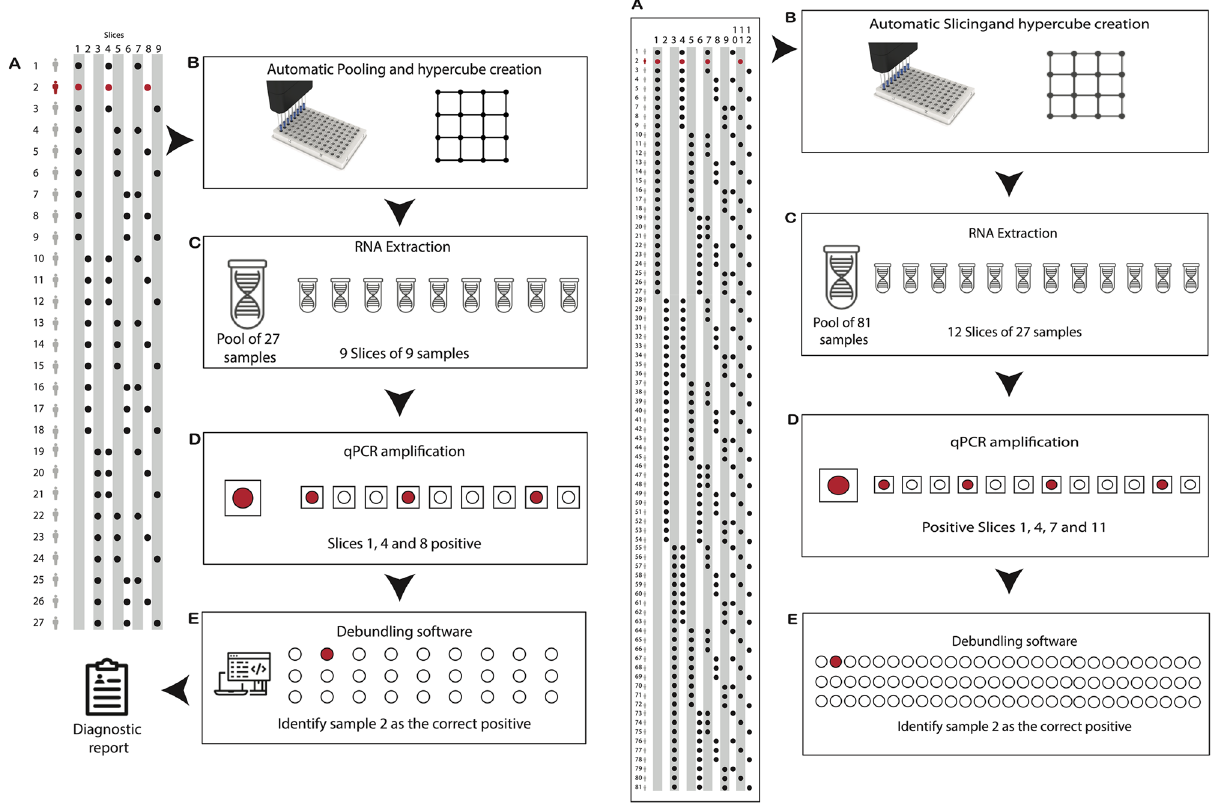
Figure 1. Examples of 3-dimensional (left) and 4-dimensional (right) hypercube workflows; ( A ) one positive sample (red, sample 2) is contained in a group of 27 samples or, respectively, 81 samples; ( B ) 9 (resp. 12) slice pools, each consisting of 9 (resp. 27) sub-samples, are created using a liquid handling robot; ( C ) RNA extraction is done on the group pool of 27 (resp. 81) samples (1 reaction) and 9 (resp. 12) slice pools (9 or 12 reactions); ( D ) qPCR results are positive for the group of 27 (resp. 81) samples and the respective slices 1, 4 and 8 (resp. 1, 4, 7, and 11); ( E ) De-bundling software is used for the automatic determination of the positive sample in the hypercube and for generating individual diagnostic